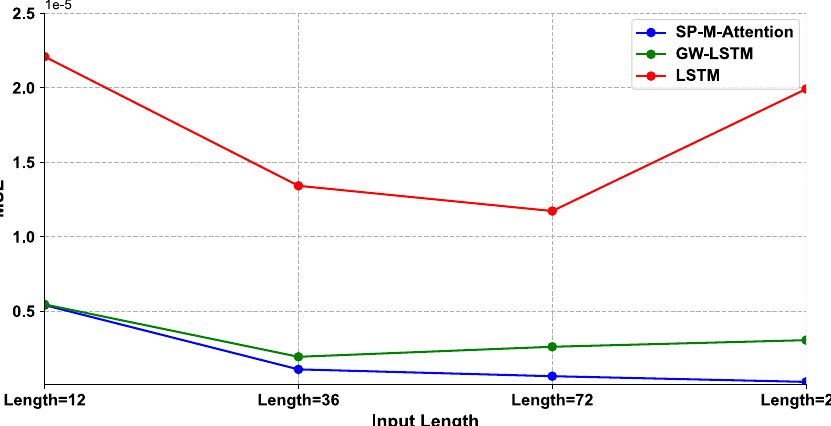
Figure 7. The LOSS (MSE) trends of SP-M-Attention, GW-LSTM, and LSTM models under different input lengths.